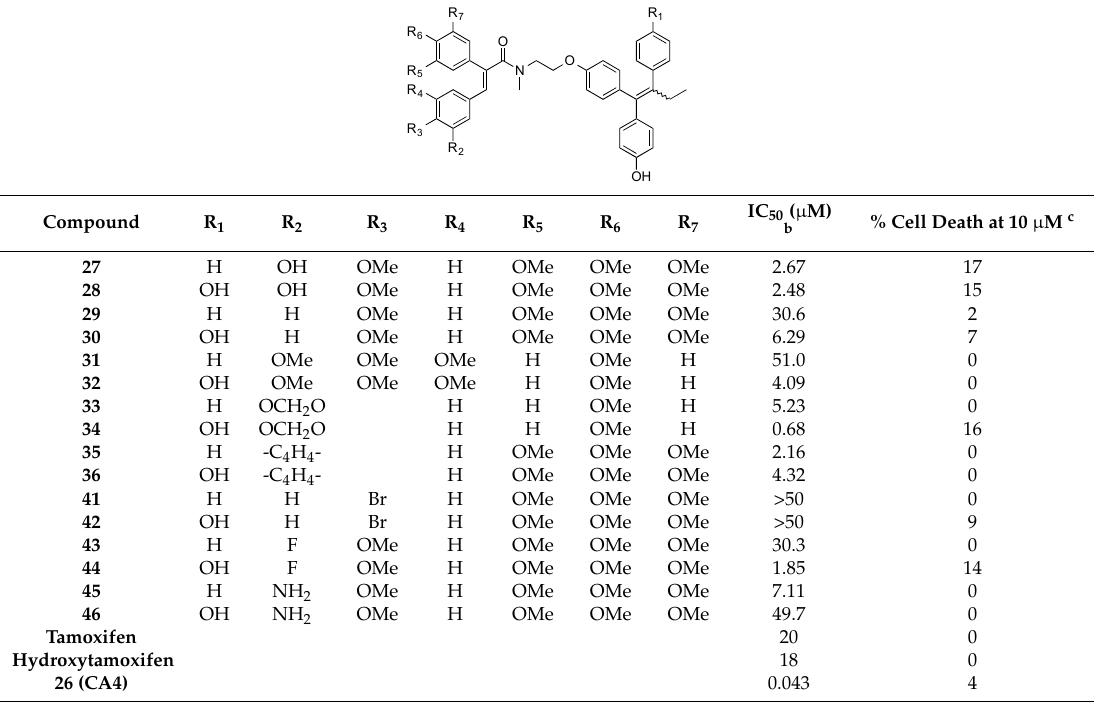
Table 3. Antiproliferative effects of selected conjugate compounds in MDA-MB-231 human breast cancer cells a .